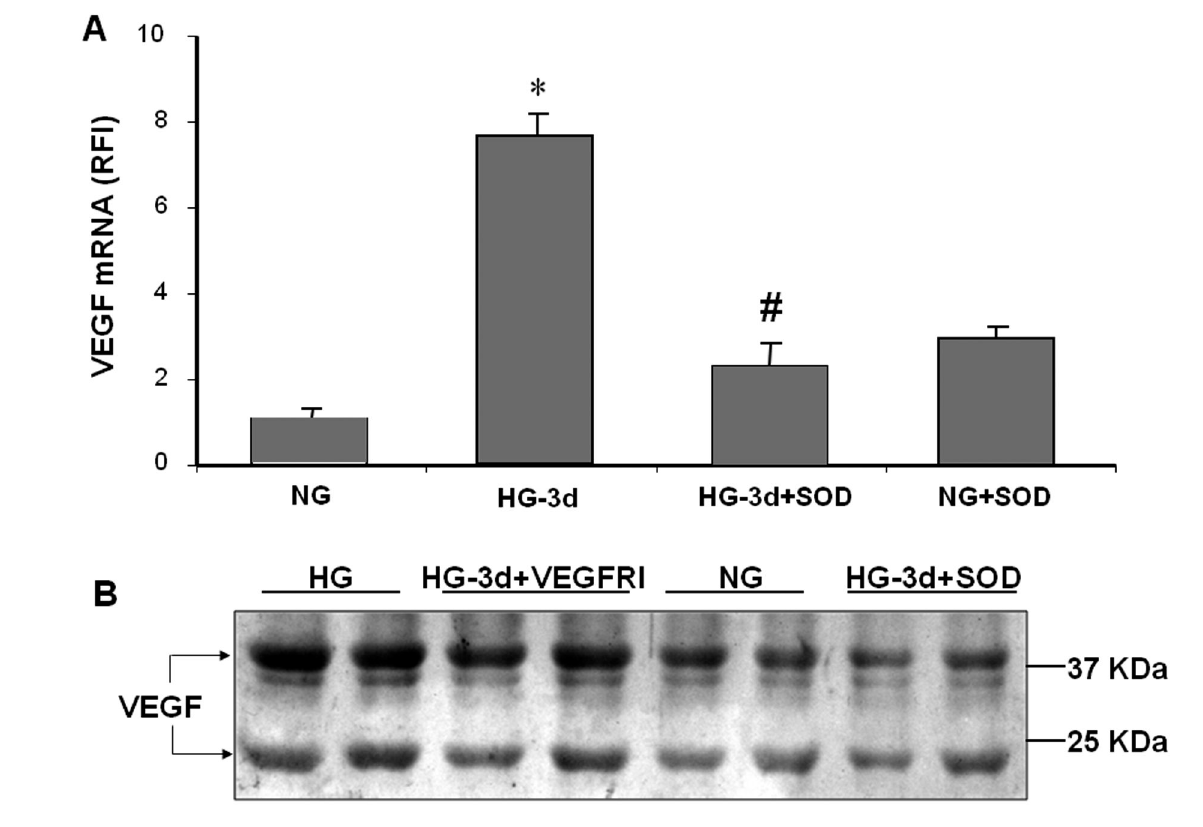
Figure 2. PEG SOD prevents HG glucose induced VEGF expression. Quantitative RT-PCR and Western blotting analyses were performed with RNA and protein isolated from endothelial cells cultured for 3 days in serum-free medium containing 5.5 mM glucose (NG) or 25 mM glucose (HG) with or without superoxide dismutase (SOD, 80 U/ml) or VEGFR inhibitor (VEGFRI, 2 µM). HG treatment increased VEGF mRNA levels as compared with NG treated cells and this effect was blocked by SOD (A). Western blot analysis confirmed increased levels of VEGF in conditioned media from HG treated endothelial cells as compared with the NG control and HG + SOD cultures